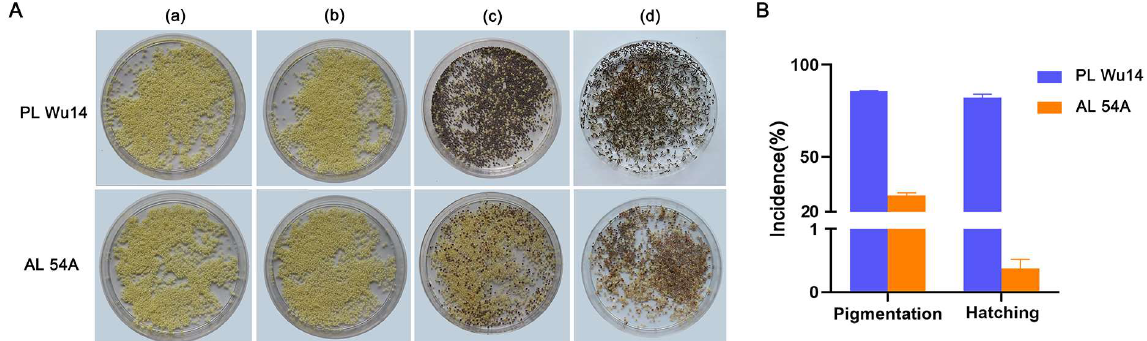
Figure 2. Incidence of parthenogenesis in the unfertilized eggs of parthenogenetic line (PL) Wu14 and its parent amphigenetic line (AL) 54A. ( A ) The phenotype of the eggs in different developmental stages. ( a ) The unfertilized eggs without treatment. ( b ) The unfertilized eggs right after thermal treatment. ( c ) The unfertilized eggs six days after thermal treatment. ( d ) The unfertilized eggs three days after hatching (i.e., 15 days after thermal treatment). ( B ) The incidence of parthenogenesis. The pigmentation rate is the ratio of the number of pigmented eggs to the total number of eggs treated. The hatching rate is the ratio of the number of eggs that hatched into larvae to the total number of eggs treated. The pigmentation rate was calculated six days after thermal treatment. The hatching rate was determined three days after hatching. The value of each fraction was the mean ± standard deviation ( n = 3). Pigmentation rate and hatching rate data are the averages of three replicates (each replicate contains 0.2 g of eggs obtained from mixed samples containing